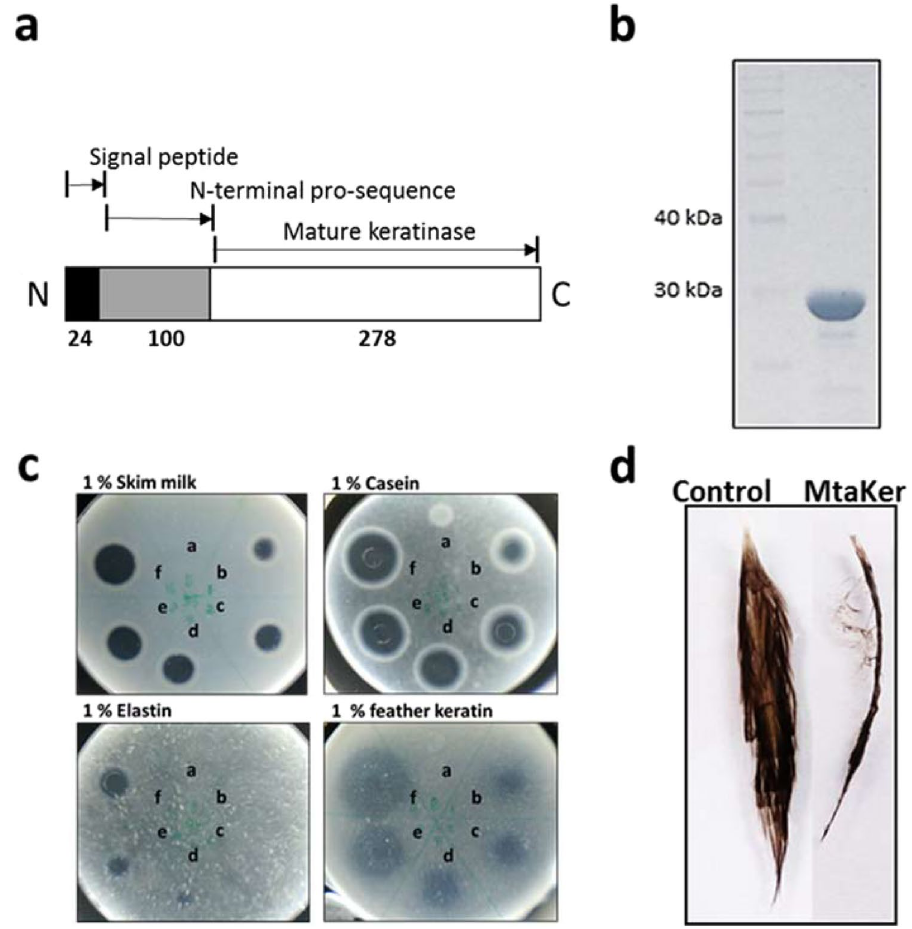
Figure 3. Domain structure and determination of rMtaKer keratinase proteolytic activities. ( a ) The three- domain structure of rMtaKer represents the positions of the signal peptide (pre, 24 amino acid residues), N-terminal pro-sequence (N-pro, 100 residues), and mature keratinase (278 residues). ( b ) The rMtaKer keratinase exhibited autoprocessing activity into mature keratinase with the molecular weight of 28 kDa. ( c ) A broad range of rMtaKer proteolytic activities, easily digesting 1% skim milk, casein, elastin, and feathers for 12 hours at 55 °C. For agar diffusion assay, disk filter papers impregnated with the different amount of rMtaKer were placed on the agar plate containing different protein substrates. The protease activities were assessed by the diffused digested zone. For better demonstration of protease activities, the disk papers were removed. The 0 μ g, 1 μ g, 2 μ g, 4 μ g, 8 μ g and 16 μ g of keratinases are labeled as a, b, c, d, and e, respectively. ( d ) The 0.1 mg of the purified rMtaKer degraded whole chicken feather after overnight incubation at 55